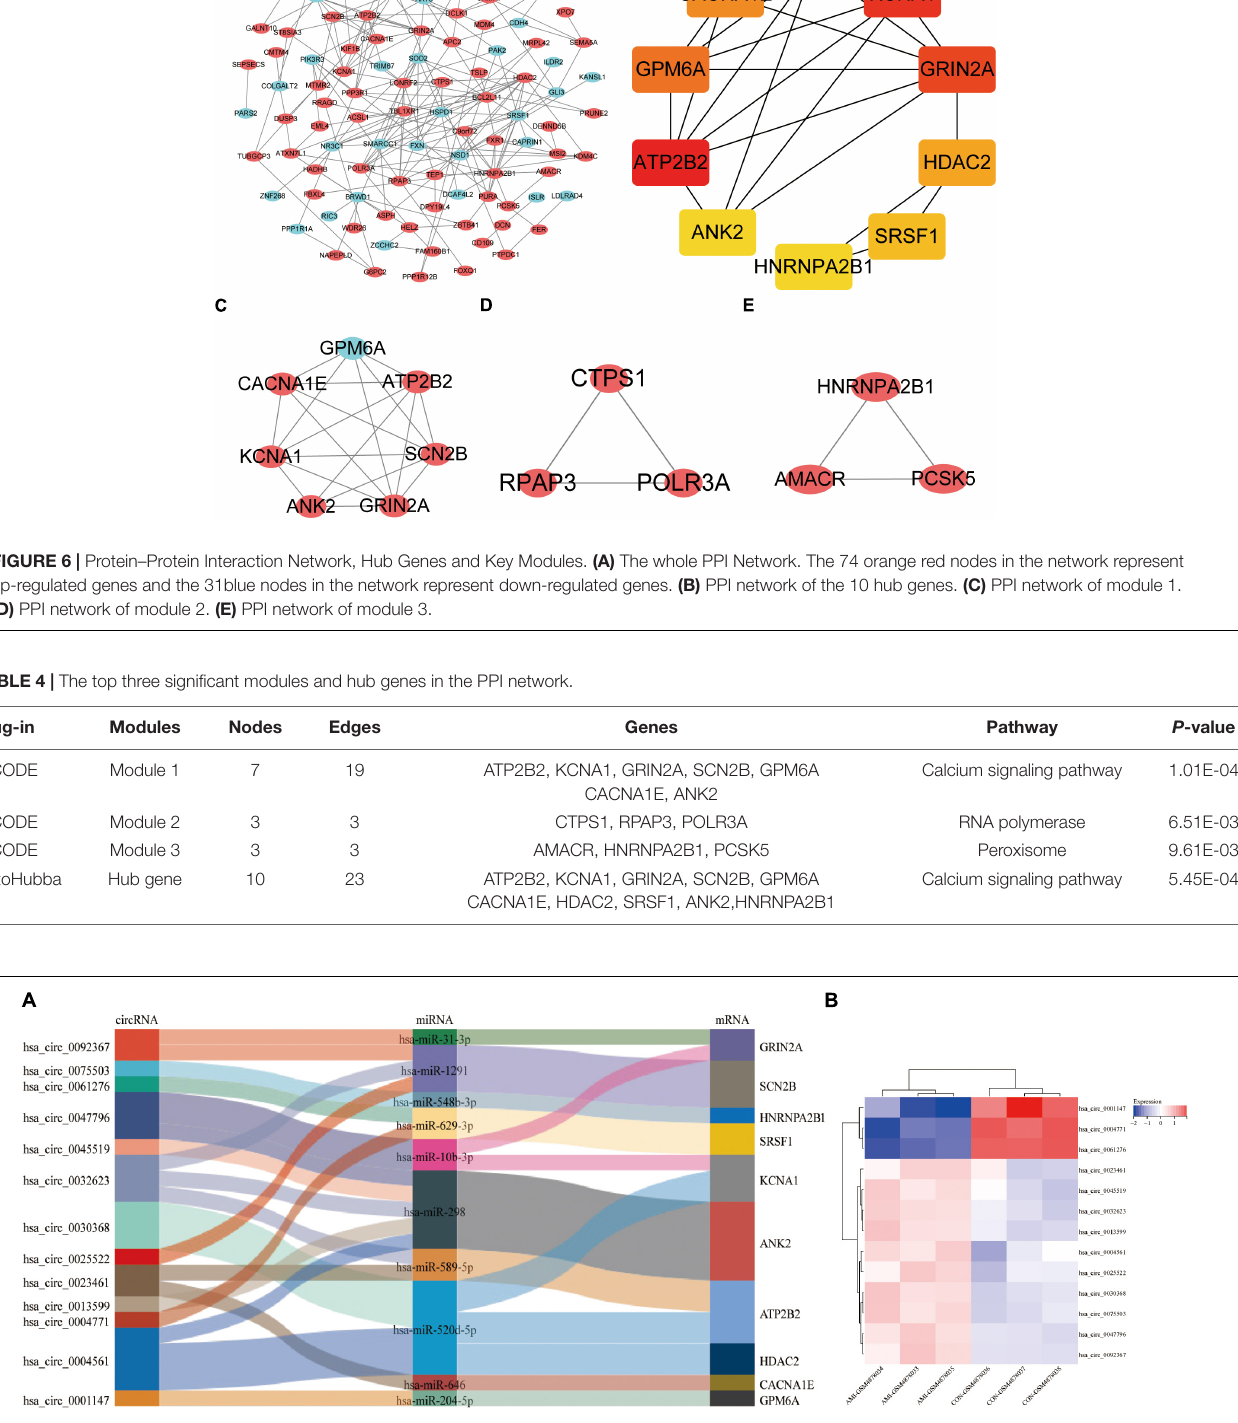
FIGURE 7 | Hub gene Related circRNAs and miRNAs. (A) The sankey diagram of the circRNA-miRNA-Hub gene network. (B) Heatmap of hub gene-related circRNAs.